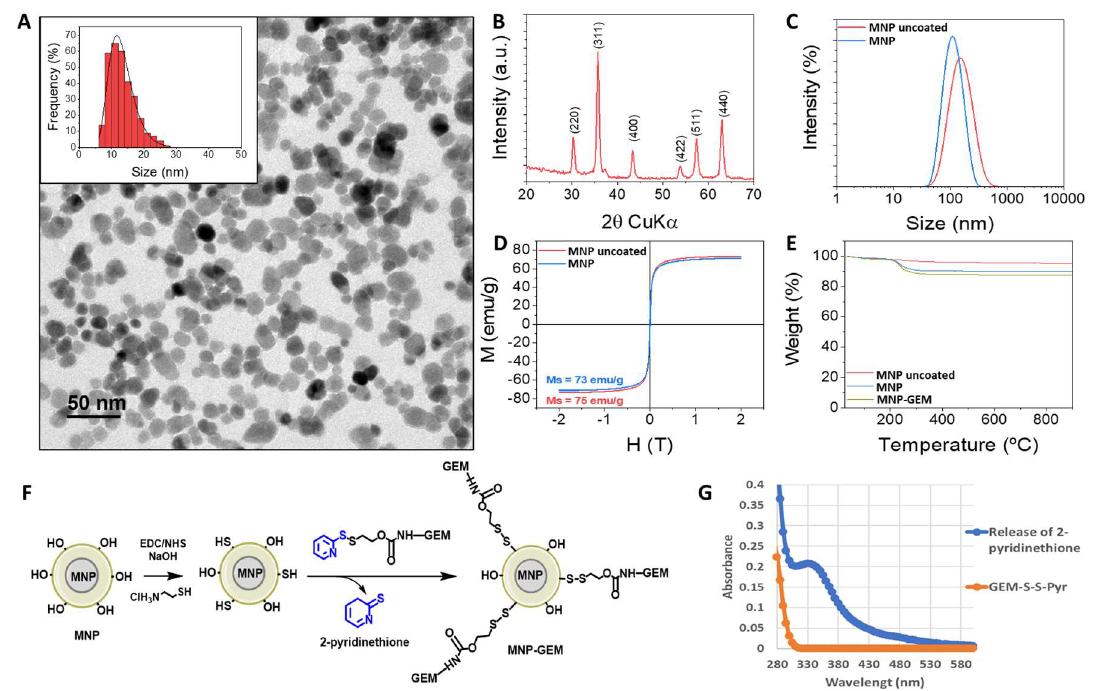
Figure 1. ( A ) TEM micrographs and size distributions (inset) of 14 nm γ -Fe 2 O 3 cores (MNP uncoated); ( B ) X-ray diffraction pattern of MNP uncoated prepared by coprecipitation; (hkl) indices corresponding to a maghemite phase are included for peak identification; ( C ) Hydrodynamic size distribution of MNP uncoated and after dextran coating (MNP); ( D ) Magnetiza- tion curves at room temperature of MNP uncoated and MNP; ( E ) Thermogravimetric analyses of MNP uncoated, MNP, and MNP-GEM; ( F ) General scheme of functionalization of MNP with GEM (MNP-GEM) via disulfide bonds; ( G ) UV spectra of GEM immobilization. The absorbance at λ 343 corresponds to the 2-pyridinethione released during the functionalization of